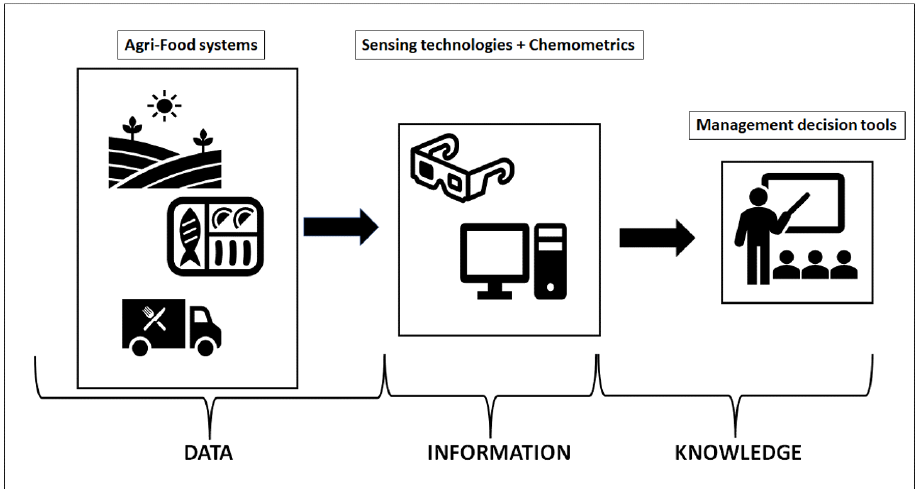
Figure 1. The combination of sensing technologies with chemometrics — moving from data to information and